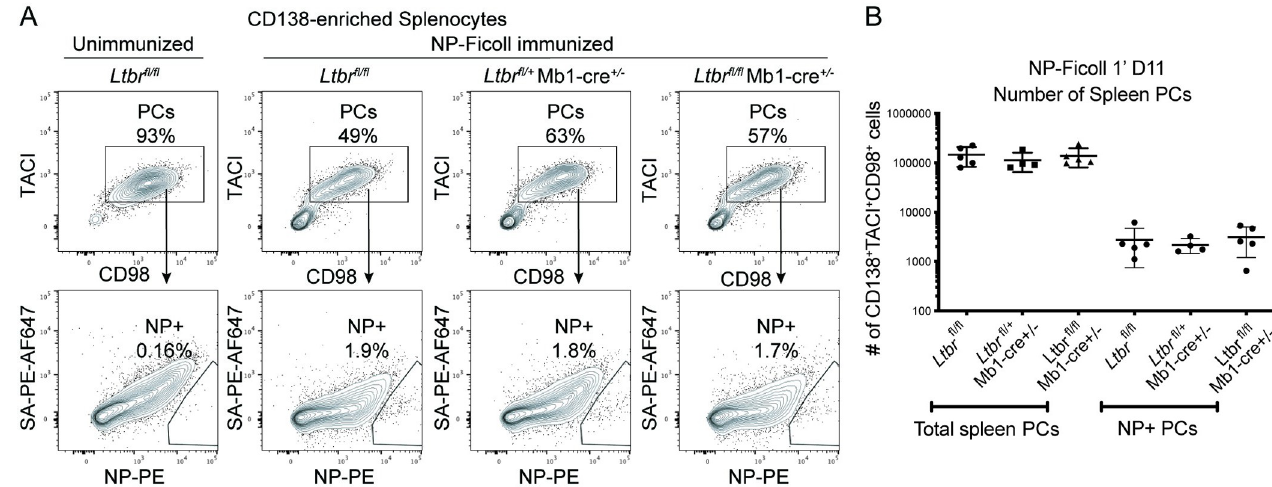
Fig 3. LT β R expression in B cells is not required for PC responses to a T-independent antigen. Ltbr fl/fl Mb1-cre +/- or control ( Ltbr fl/fl or Ltbr fl/+ Mb1-cre +/- ) mice were immunized with NP-Ficoll for 11 days. (A) Representative FACS plots of live Dump - CD138-enriched splenocytes from an unimmunized Ltbr fl/fl mouse and immunized mice (top row) with gates on TACI + CD98 + PCs. NP + PCs cells were identified as NP16-PE + and decoy SA-PE-AF647 - (bottom row). (B) Numeration of total and NP + PCs in spleens of immunized mice. Data shown in all panels are representative of two independent experiments (n = 4–5 mice per